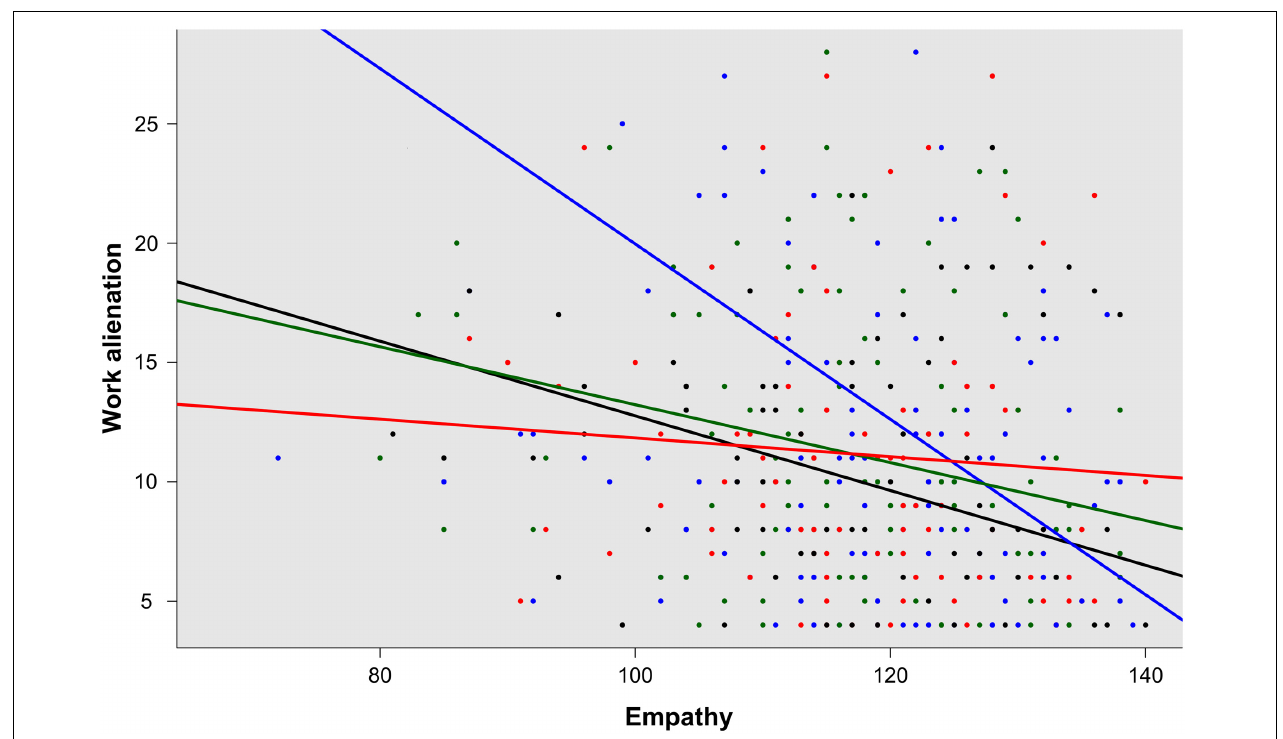
FIGURE 1 | Regression analysis for “occupation by sex” groups, male physicians (black), women physicians (green), male nurses (blue), and women nurses (red), according to alienation by empathy ( p =